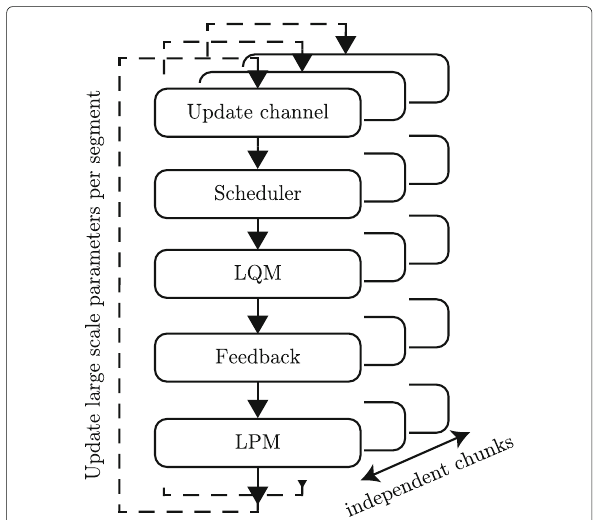
Fig. 3 Main simulation loop of the simulator. The main loop consists of an outer loop over chunks that are processed independently. At the beginning of the inner loop over TSs, the MF values are updated if a new segment begins. For each iteration, five steps are performed, which are updating the channel (i.e., the small-scale fading), distribution of the available resources to users by the scheduler, calculation of the postequalization SINR in the LQM, calculation of feedback, and finally mapping of SINR to BLER in the LPM